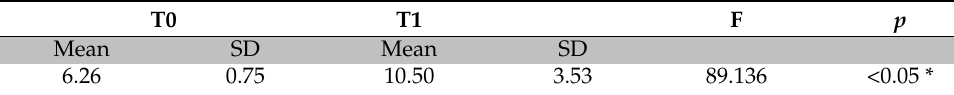
Table 5. Effect within factor on task 2 (SE).